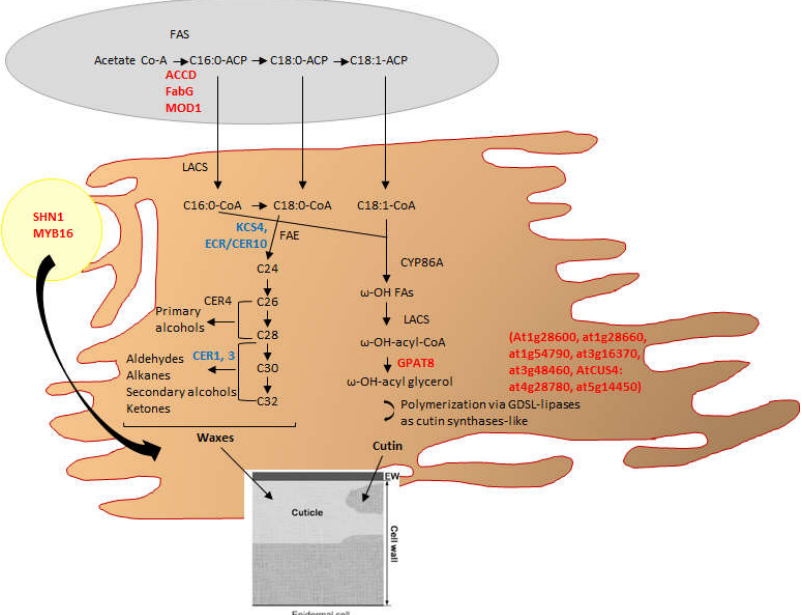
Figure 5: In green the chloroplast, in brown the ER and in yellow the nucleus. Genes written in red are induced, genes written in blue are repressed. FAS: Fatty Acid Synthase complex to which belong ACCD (carboxytransferase beta subunit of the Acetyl-CoA carboxylase complex), FabG (β-ketoacyl ACP- reductase) and MOD1 (enoyl-ACP-reductase) functions. FAE: fatty acid elongase complex. KCS4 (3- ketoacyl-CoA synthase 4) and ECR/CER10 (trans-2-enoyl-CoA reductase) belong to the FAE complex.